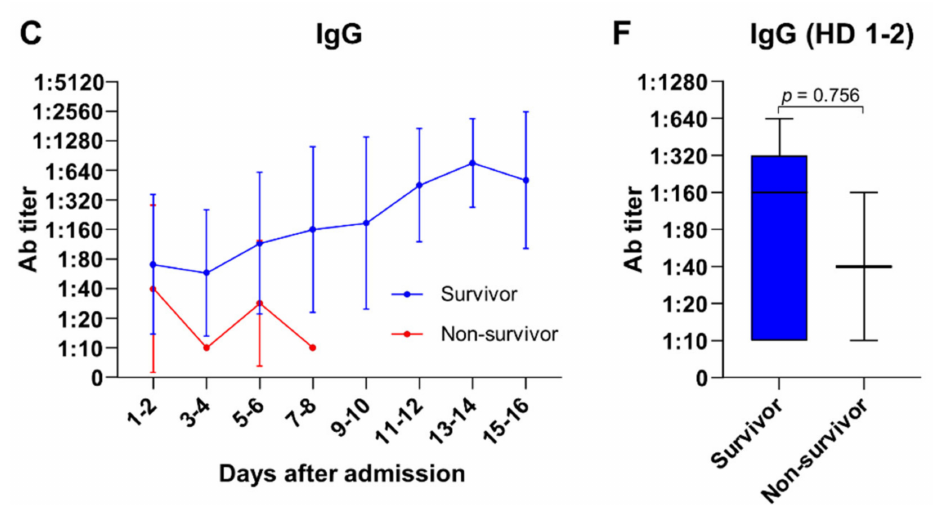
Figure 1. Plasma SFTS viral load and antibody titer in patients with SFTS. Both segment S (seg S) and M (seg M) titers were significantly higher in non-survivors than in survivors and increased during hospitalization ( A , B ). The SFTS viral load (hospital days 1–2) was significantly higher in non-survivors ( D , E ). The plasma antibody titer against SFTSV increased in survivors during hospi- talization but decreased in non-survivors ( C ). There were no differences between the initial (hospital days 1–2) anti-SFTSV-IgG titers of the survivors and non-survivors ( F ). Blue, survivor; red, non- survivor. ** p < 0.01, *** p < 0.001, **** p <